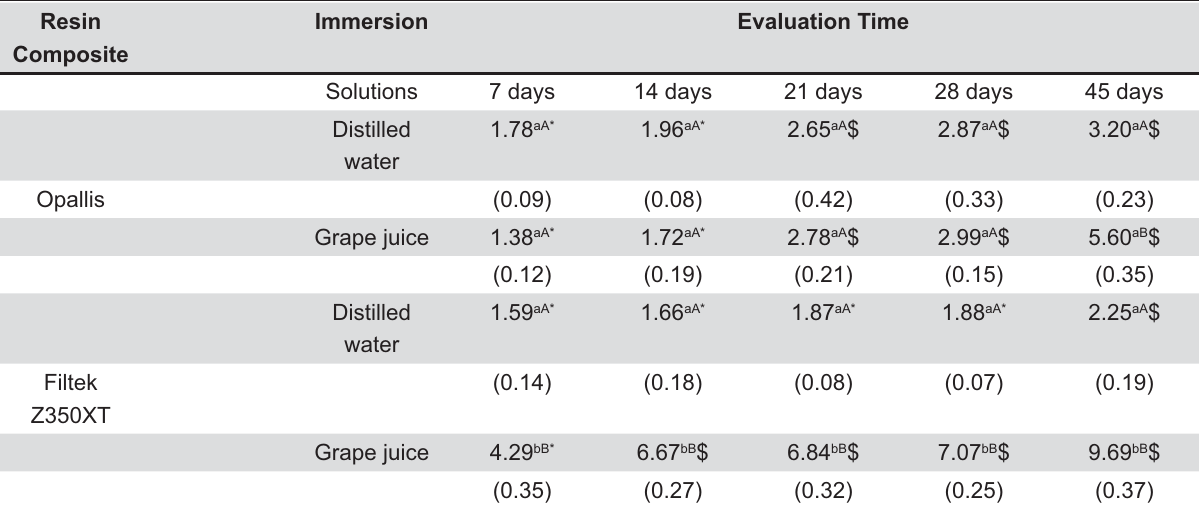
Table 2- (cid:7)}(cid:20)(cid:6)(cid:11)(cid:2)(cid:7)(cid:8)(cid:2)(cid:13)(cid:6)(cid:11){(cid:6)(cid:21){(cid:7){(cid:20)(cid:19)(cid:3)(cid:6)(cid:13)(cid:3)(cid:14)(cid:11)(cid:2)(cid:24)(cid:7)(cid:14)#(cid:7)(cid:5)(cid:14)(cid:4)(cid:14)(cid:21)(cid:7)(cid:2)(cid:13)(cid:6)(cid:31)(cid:3)(cid:4)(cid:3)(cid:13)‘(cid:7)(cid:8)(cid:25)(cid:26)(cid:24)(cid:7)(cid:14)#(cid:7)(cid:13)Y(cid:20)(cid:7)(cid:5)(cid:14)(cid:12)>(cid:14)(cid:2)(cid:3)(cid:13)(cid:20)(cid:2)(cid:7)$(cid:3)(cid:13)Y(cid:7)(cid:21)(cid:20)(cid:22)(cid:6)(cid:21){(cid:7)(cid:13)(cid:14)(cid:7)(cid:13)Y(cid:20)(cid:7)(cid:3)(cid:12)(cid:12)(cid:20)(cid:21)(cid:2)(cid:3)(cid:14)(cid:11)(cid:7)(cid:2)(cid:14)(cid:4)_(cid:13)(cid:3)(cid:14)(cid:11)(cid:7)(cid:6)(cid:11){(cid:7) evaluation time